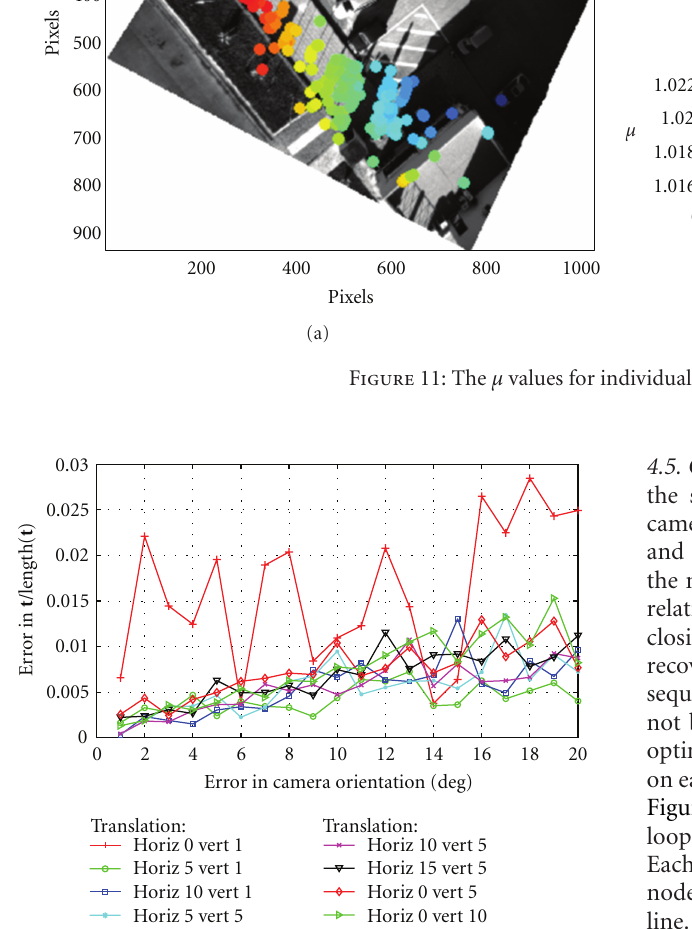
Figure 12: Relative error of the recovered translation vector in